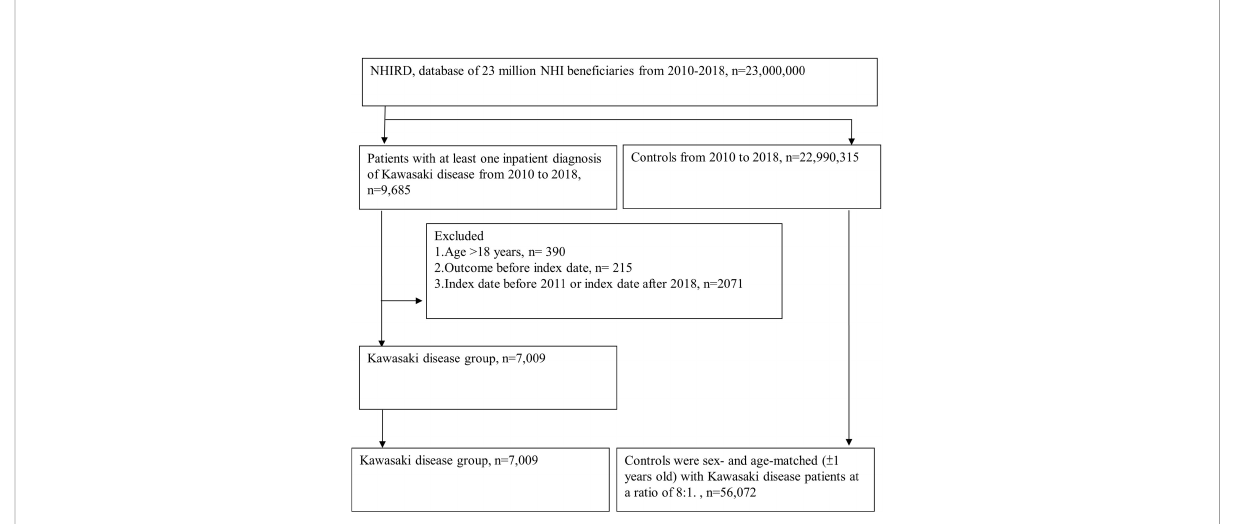
FIGURE 1 Flowchart detailing the Kawasaki-disease and non-Kawasaki-disease group